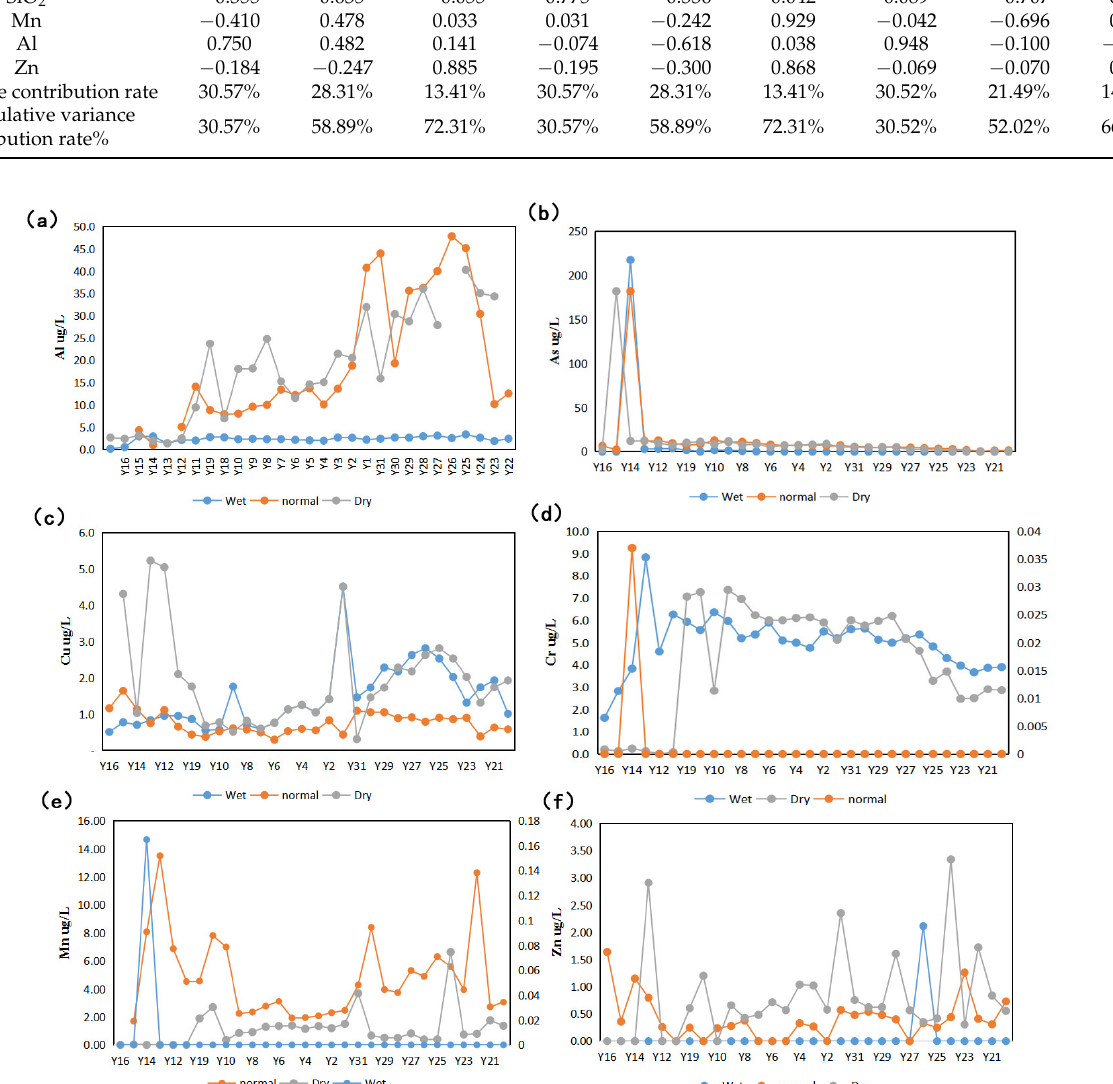
Figure 3. Temporal and spatial variation of major heavy metals in the main stream of the Yarlung Tsangpo River. ( a ) Spatiotemporal variation characteristics of heavy metal Al. ( b ) Spatiotemporal variation characteristics of heavy metal As. ( c ) Spatiotemporal variation characteristics of heavy metal Cu. ( d ) Spatiotemporal variation characteristics of heavy metal Cr. ( e ) Spatiotemporal variation characteristics of heavy metal Mn. ( f ) Spatiotemporal variation characteristics of heavy metal Zn. Y16-Y21 represents the sampling point location in the main stream of the Yarlung Tsangpo River.